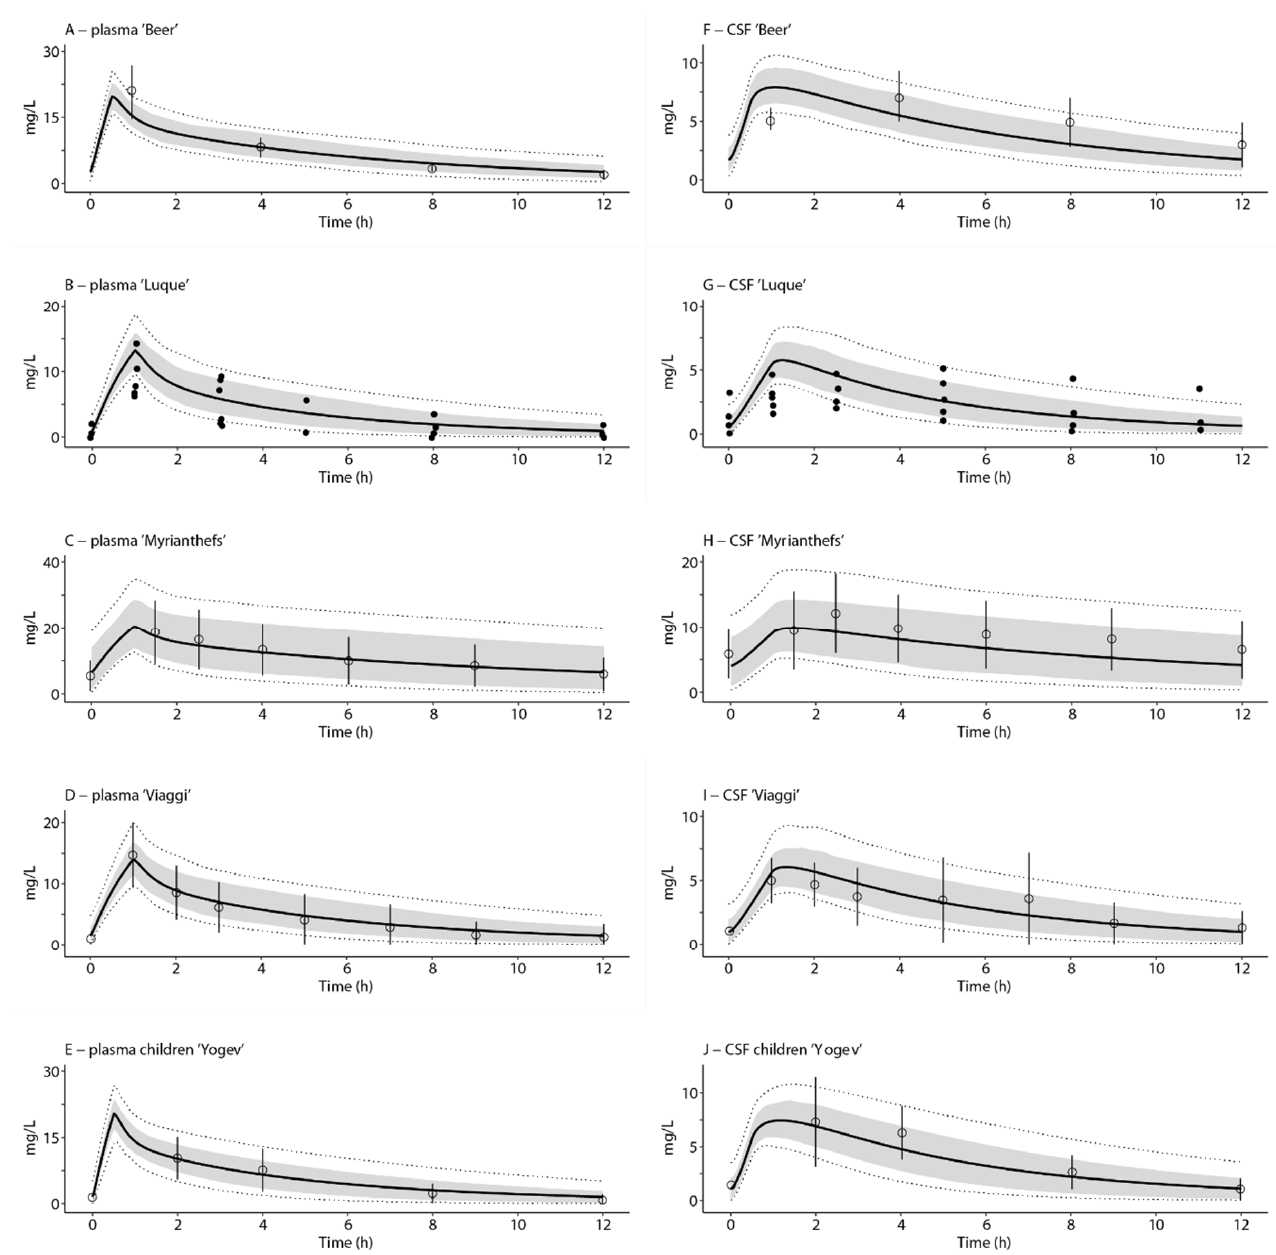
Figure 2. Simulations of linezolid concentration–time profiles in plasma ( A – E ) and cranial CSF ( F – J ) in critically ill adult and paediatric patients. Figures relate to intravenous administration of 600 mg linezolid twice daily for >two days in adults, as well as 10 mg/kg intravenous administration twice daily for two days in children (0.25–21 years). The x -axis indicates time after the last dose. The solid black lines indicate mean simulated profiles, the grey areas represent the area between the 16th and 84th percentile (equal to the standard deviation) of the mean, and the dotted lines indicate the 5th and 95th percentiles of the mean. Closed dots indicate measured individual data derived from the literature [6], and open circles indicate the mean with reported standard deviation derived from the literature [5,7,8,33]. The names in the headings of the figures relate to the first authors of the papers from which clinical data points were